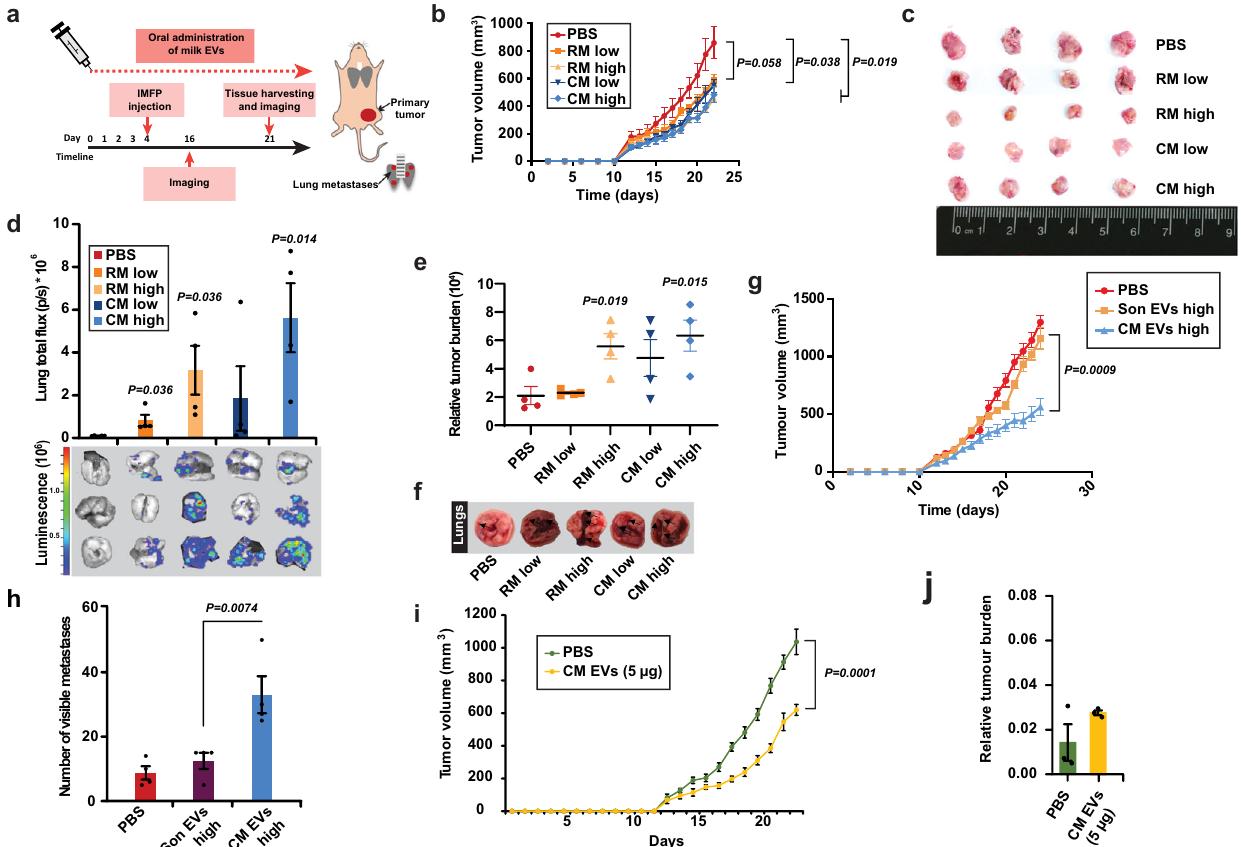
Fig. 5 Bovine milk-derived EVs increase metastasis of breast cancer cells. a Schematic representation of intramammary fat pad injections (IMFP) of 4T1.2 breast cancer cells and treatment timeline with milk-derived EVs. b Primary breast tumor volume in immunocompetent mice treated with milk- derived EVs (low dosage: 25 mg/kg; higher dosage: 50 mg/kg; n = 4). c Harvested primary tumor size from mice treated with PBS and milk-derived EVs is shown. d Quanti fi cation of ex vivo imaging of lungs from metastatic breast cancer models treated with PBS and milk-derived EVs. Total lung fl ux to quantify breast cancer metastasis to lungs is depicted ( n = 4). e Relative metastatic tumor burden is depicted ( n = 4). f Pathological examination of lung metastases on the surface of the tissue. g Primary breast tumor volume in immunocompetent mice orally administered with PBS, sonicated and intact milk- derived CM EVs (higher dosage: 50 mg/kg; n = 5). h Pathological examination of lung metastases and quanti fi cation of visible metastases on the surface of the lungs from mice orally administered with PBS, sonicated and intact milk-derived CM EVs ( n = 5). i Primary breast tumor volume in immunocompetent mice orally administered with PBS ( n = 8) and CM EVs (5 µ g; n = 9). j Relative metastatic tumor burden is depicted ( n = 3). Mice exclusion reason: for measuring the relative tumor burden, 3 mice lungs were used randomly; the remaining mice lungs were used to isolate mCherry positive cells for a different experiment. All data are represented as mean ± s.e.m. Statistical signi fi cance was determined by unpaired two-tailed t were enriched (though not signi fi cant) in 4T1.2 cells incubated